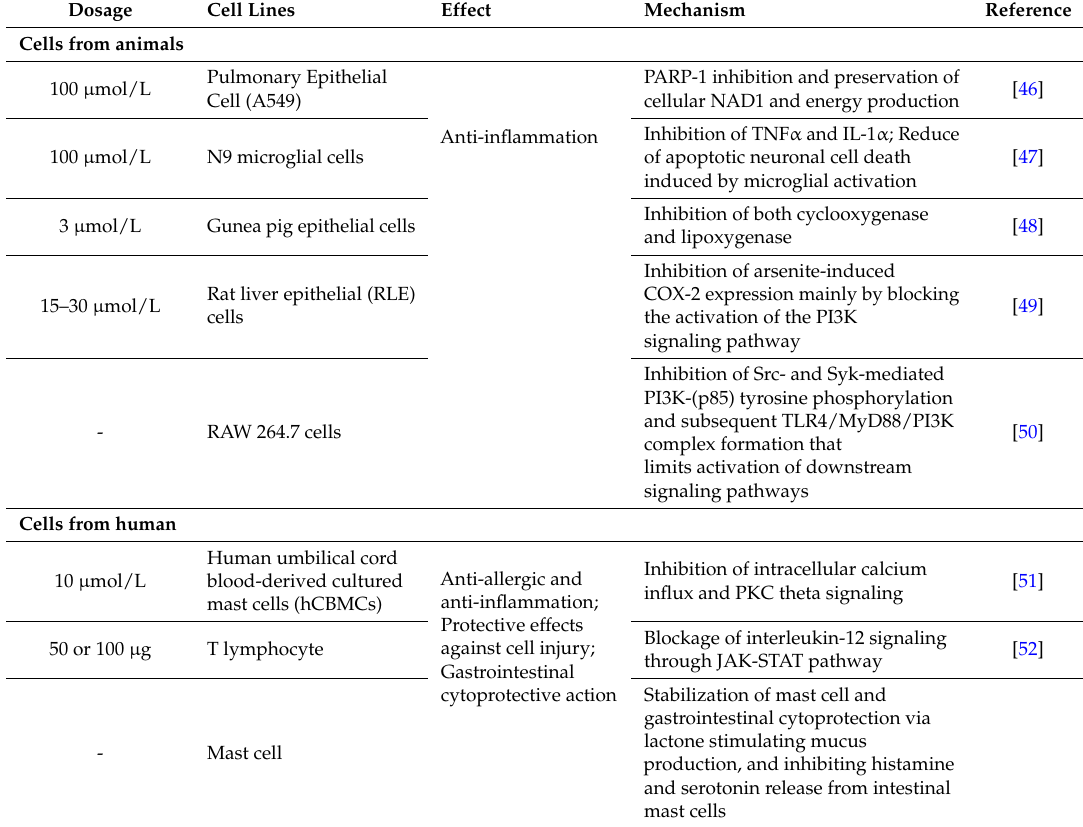
Table 1. Summary of the main effects of quercetin on inflammation and immune function in vitro . Dosage Cell Lines